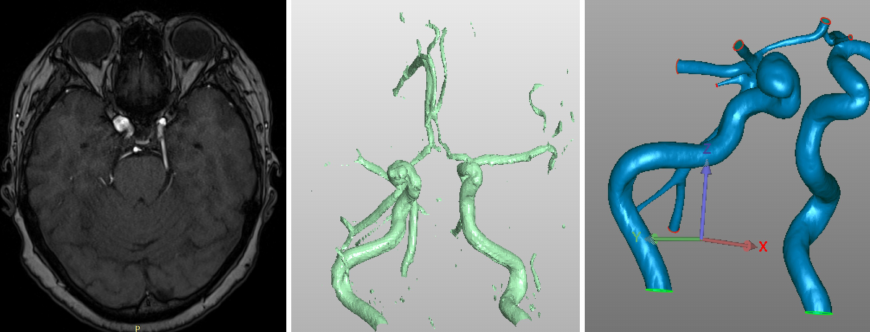
Figure 3. Overview of reconstruction process, from left to right: ( left ) a 3D model of vessels is built from a 3D CT-angio DICOM images; ( center ) Preparing continuos STL model via ITK Snap + 3D Viewer software; ( right ) finalization of the model via SolidWorks software (Boston, MA, USA).